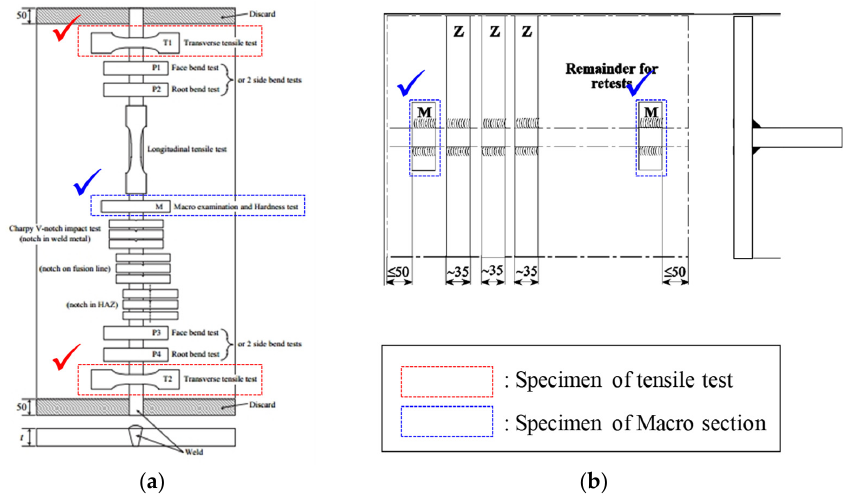
Figure 5. Extraction zone of tensile test and macro section: ( a ) Test specimen for butt welding; ( b ) Test specimen for fillet welding.